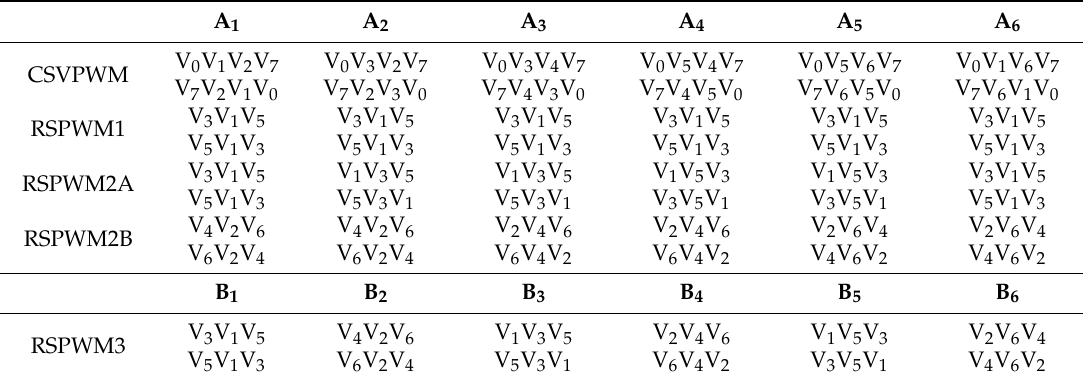
Table 2. Pulse Patterns of the CSVPWM and the